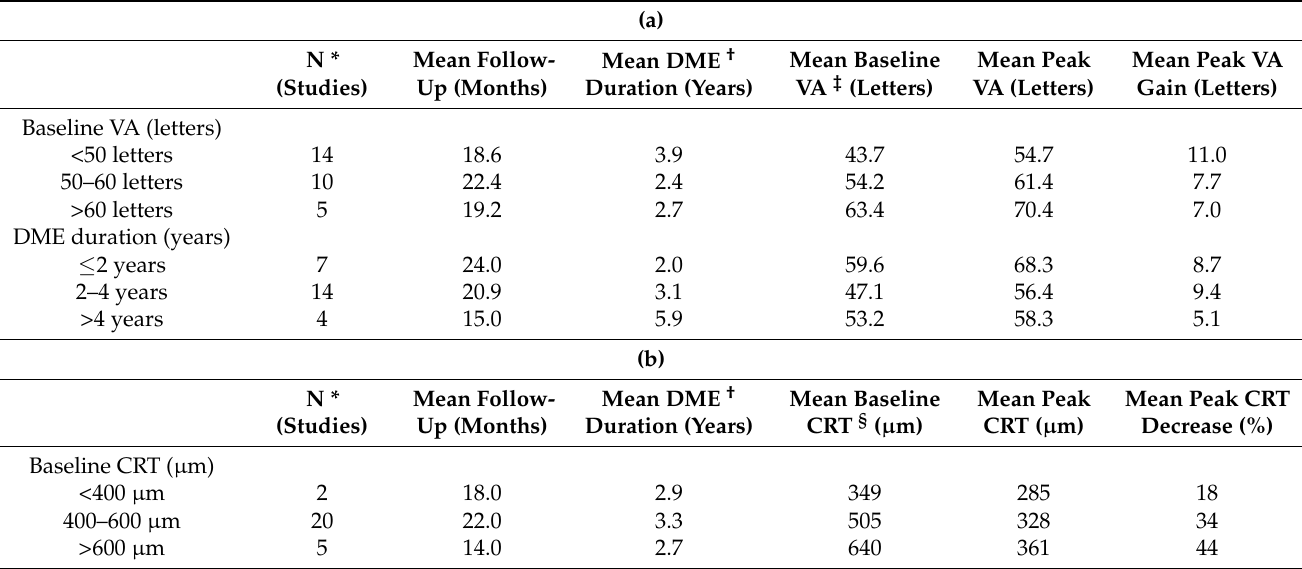
Table 2. Peak visual acuity after fluocinolone acetonide implant segmented by baseline visual acuity and duration of diabetic macular edema ( a ) and peak central retinal thickness after fluocinolone acetonide implant segmented by baseline central retinal thickness ( b ).